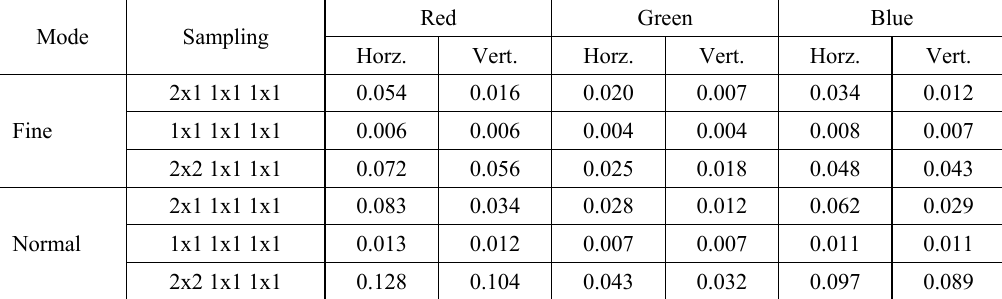
Table 4. RMS of displacements of 3600 evaluation points caused by lossy JPEG compression with 3 downsampling factors (unit: pixel)